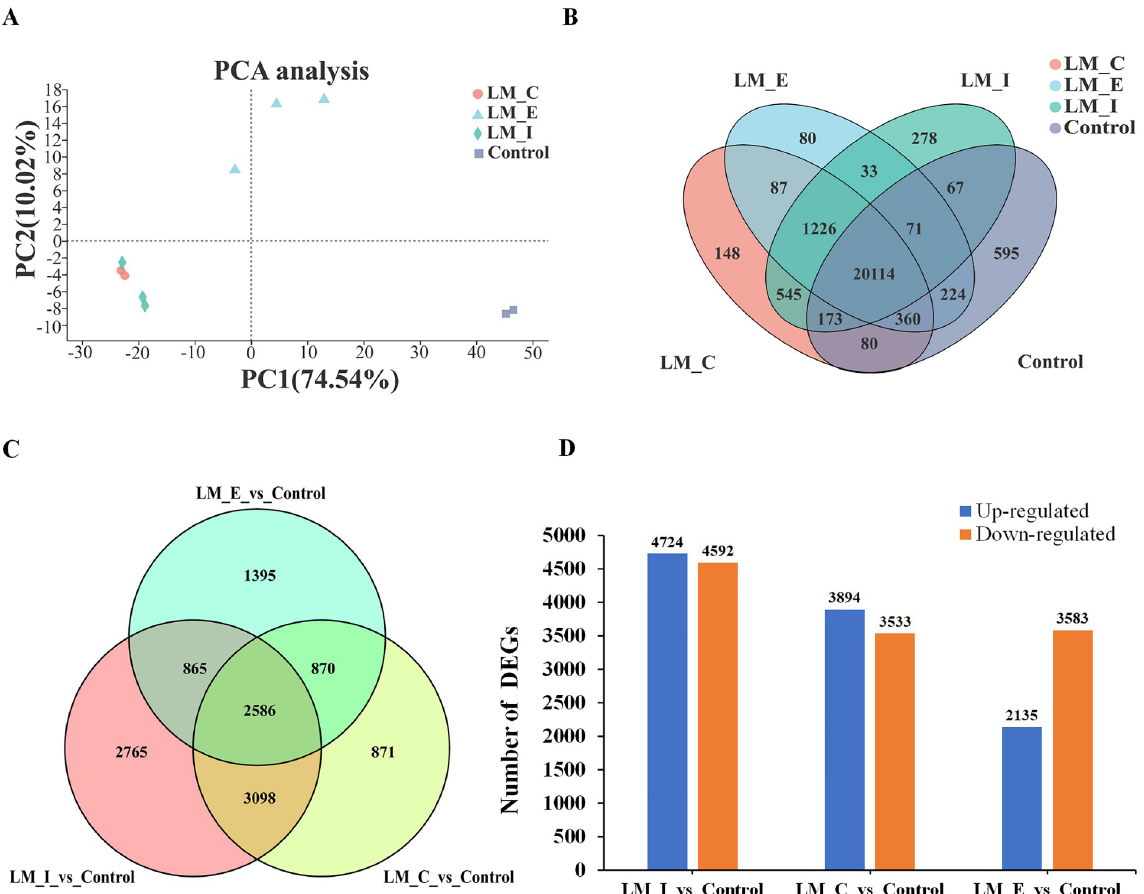
Fig 3. Expression analysis according to treatment (MD and control). (A) Principal component analysis (PCA) of gene expression. (B) Venn diagram of different samples from the MD and control treatments. (C) Venn diagram of the number of shared DEGs between different groups. (D) Upregulated and Downregulated DEGs for LM_I vs. Control, LM_C vs. Control and LM_E vs.